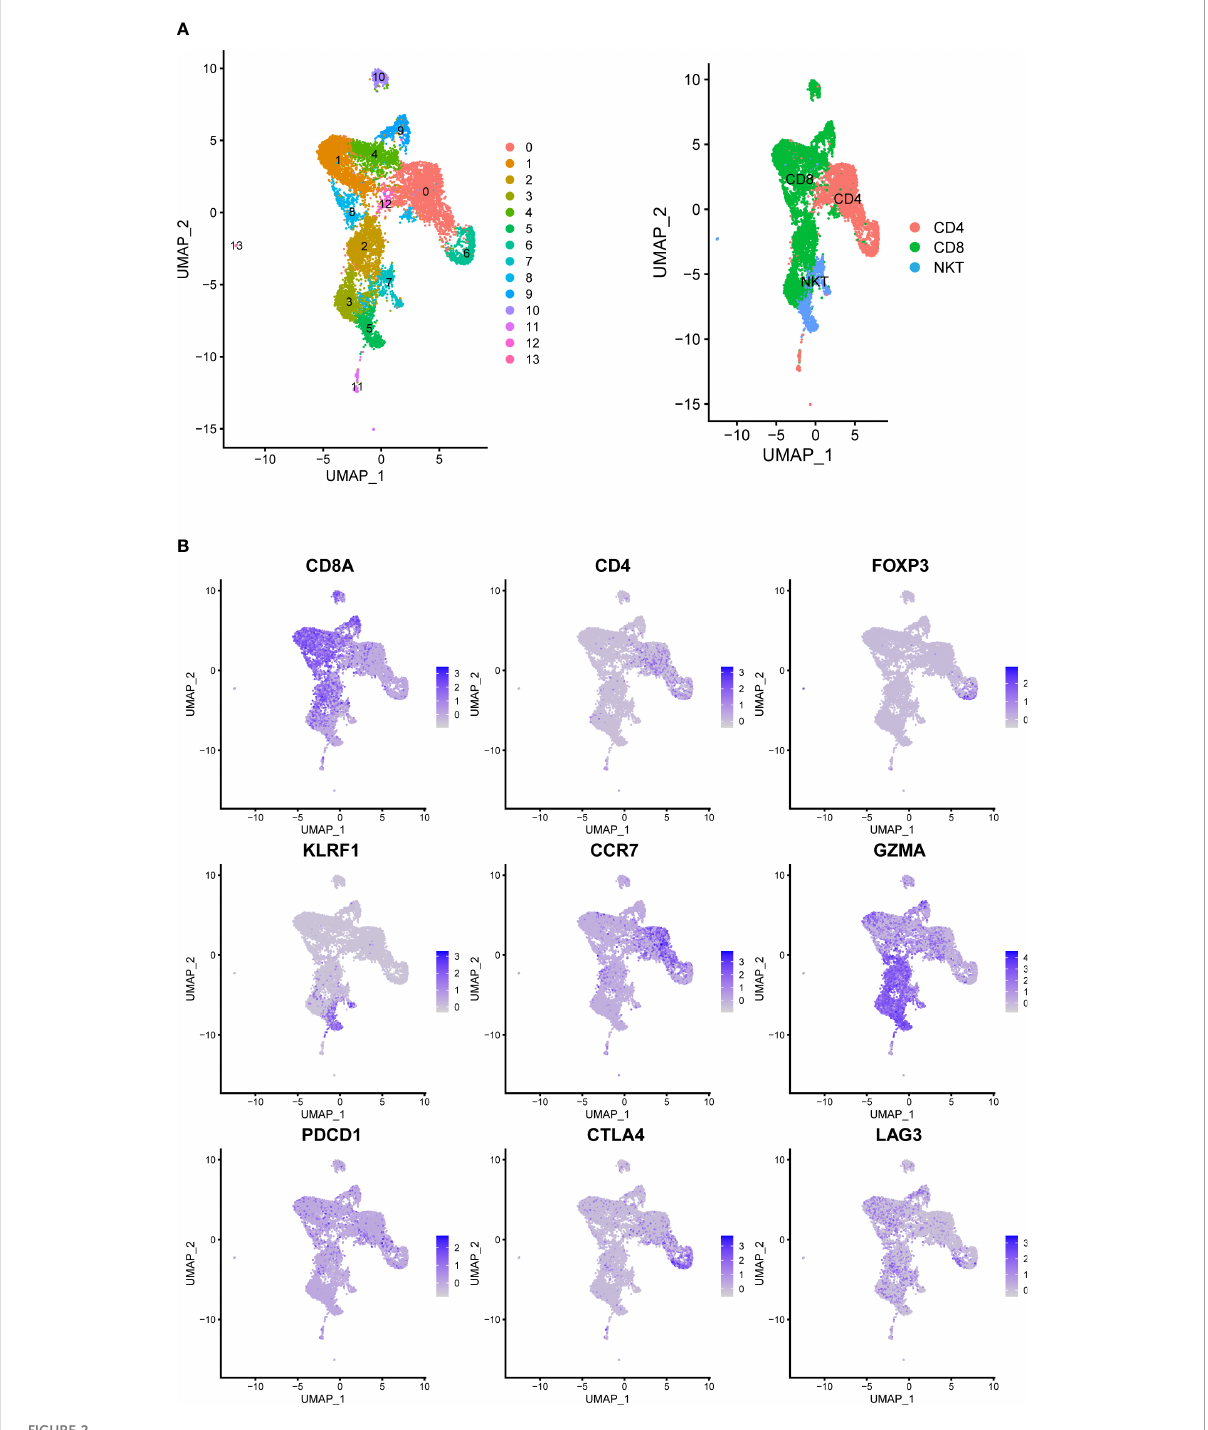
FIGURE 2 Prostate Cancer Contains Canonical T Cell. (A) UMAP of T-cells labeled by different cell types obtained from prostate tumors tissue with or without ADT (N = 4 patients). Phenotypic clusters are represented in distinct colors. (B) Relative intensity of expression of select genes superimposed on the UMAP